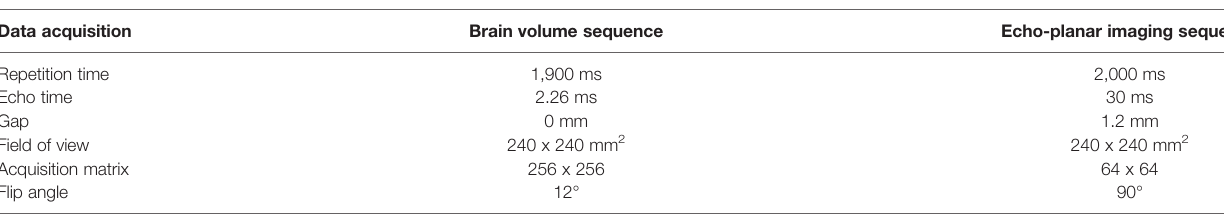
TABLE 1 | Parameters setting of the MRI scanning.